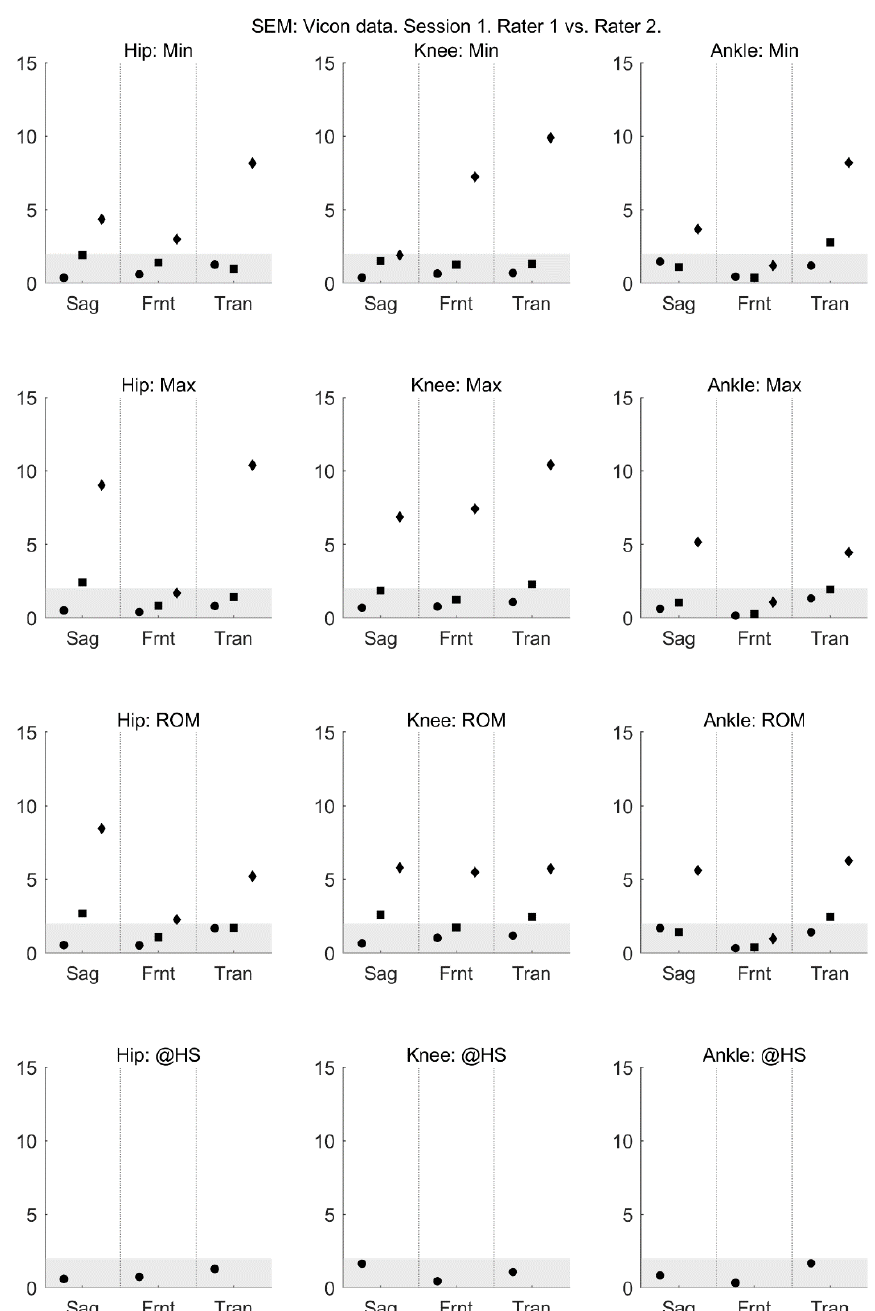
Figure A2. Within-session standard error of measurement of VICON data collected in session 1. Standard error of measurement is shown for the minimum angle (min; top row ), maximum angle (max; second row ), range of motion (ROM; third row ) and angle at heel strike (@HS; bottom row ) for the hip (left-most column), knee (centre column) and ankle (right-most column) joints in the sagittal (Sag), frontal (Frnt) and transverse (Tran) planes of movement. The three data points in each plane correspond to the walk (left-most point; circle), squat (centre point; square) and jump (right-most point; diamond) tasks. Grey shading indicates values considered to indicate excellent reliability.